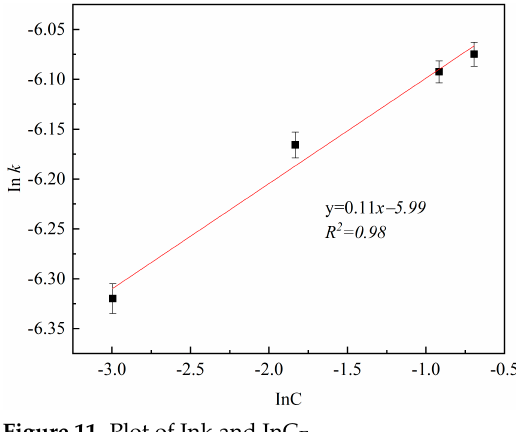
Figure 11. Plot of Ink and InC F .